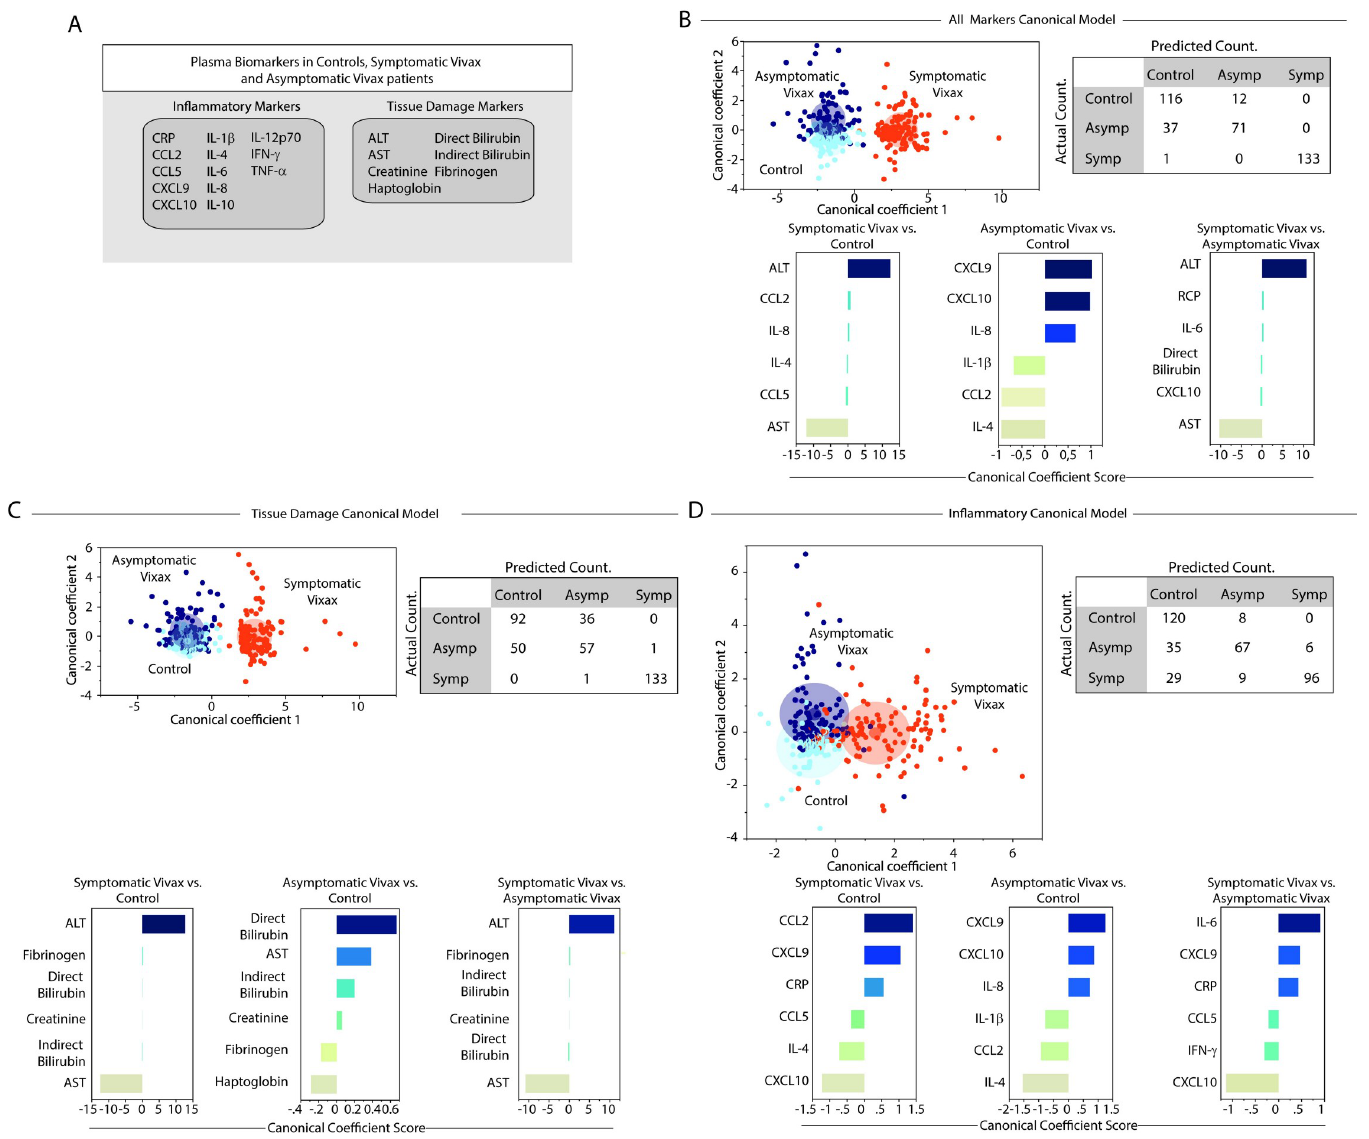
Fig 7. Using canonical correlation analysis of the degree of perturbation of inflammatory or tissue damage markers to characterize vivax malaria. (A) In an exploratory approach, a sparse canonical correlation analysis (sCCA) was used to test whether the indicated clinical groups could be distinguished based on: (B) the overall perturbation profile of all the markers measured, or combinations of (C) tissue damage markers or (D) inflammatory markers only. Each circle represents a patient, according to the clinical groups, as indicated. Lower panels show the canonical coefficient scores calculated to identify the biomarkers responsible for the distinctions between groups in each sCCA model as indicated. Tables show the performance of each developed canonical model. Rows refer to the actual counts, whereas columns the predicted count. Abbreviations (alphabetic order): ALT: alanine aminotransferase; AST: aspartate aminotransferase; CCL: C-C motif chemokine ligand; CXCL: C-X-C motif chemokine ligand; CRP: C-reactive protein; IFN: interferon; IL: interleukin; TNF: tumor necrosis